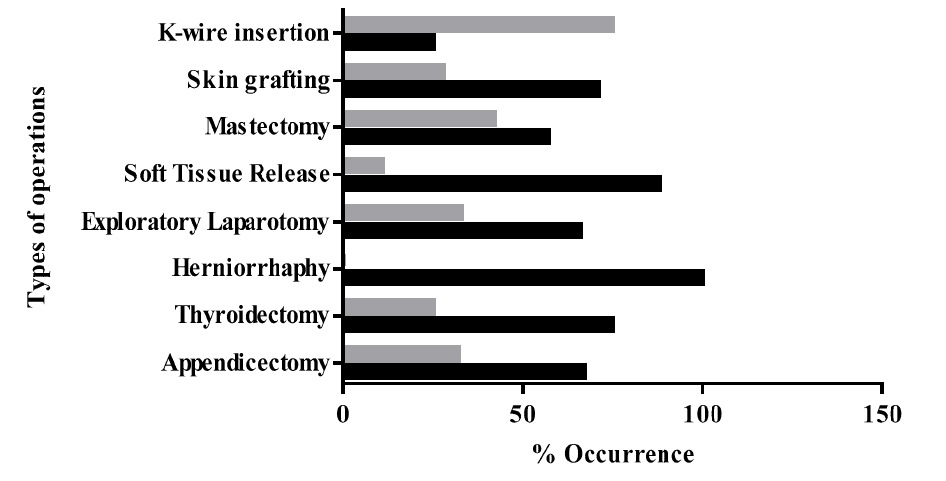
Figure 1. Type of operations and occurrence of SSI.